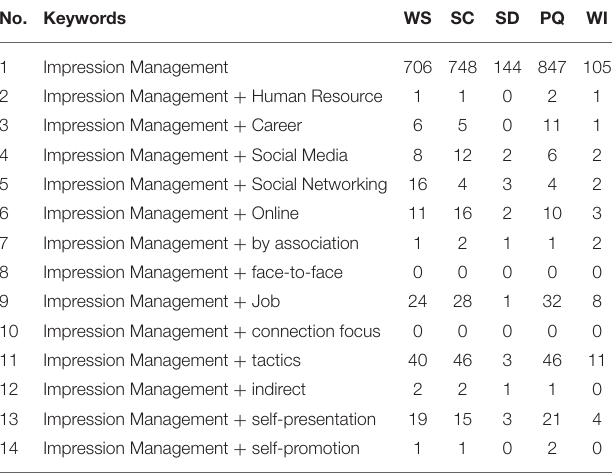
TABLE 1 | Summary of search